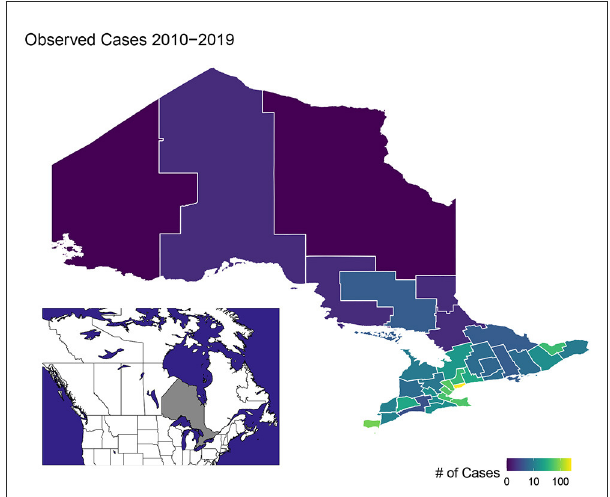
FIGURE3 Map of total human West Nile virus cases in Ontario from 2010 to